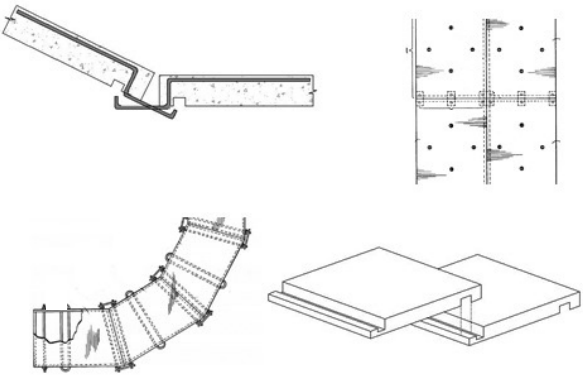
Figure 10. Interlocking arrangement for light